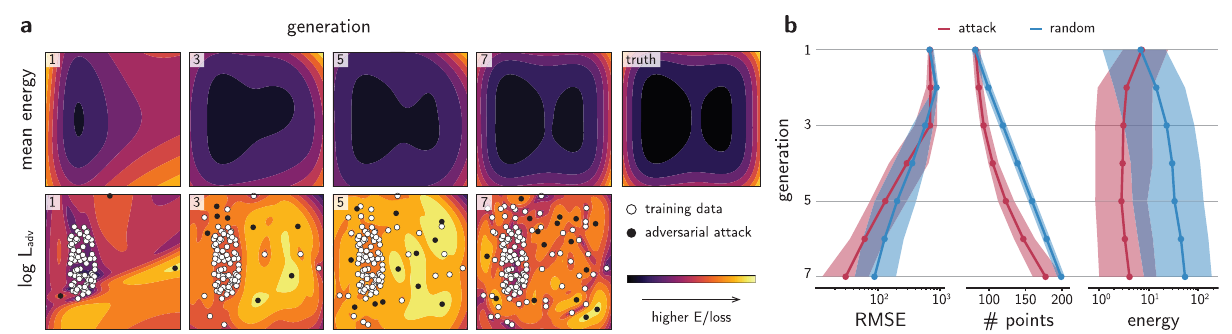
Fig. 3 Adversarial attacks applied to a toy potential. a Evolution of the PES of a 2D double well predicted by an NN committee. Adversarial examples (black dots) are distortions from original training data (white dots) or past adversarial examples (gray dots) that maximize the adversarial loss L adv . The plotting intervals are [ − 1.5, 1.5] × [ − 1.5, 1.5] for all graphs. The generation of the NN committee is shown in the top left corner of each graph. b Evolution of the root mean square error (RMSE), number of training points, and energy of the data points sampled using the adversarial attack strategy (red) or by randomly distorting the training data (blue). The solid line is the median from more than 100 experiments, and the shaded area is the